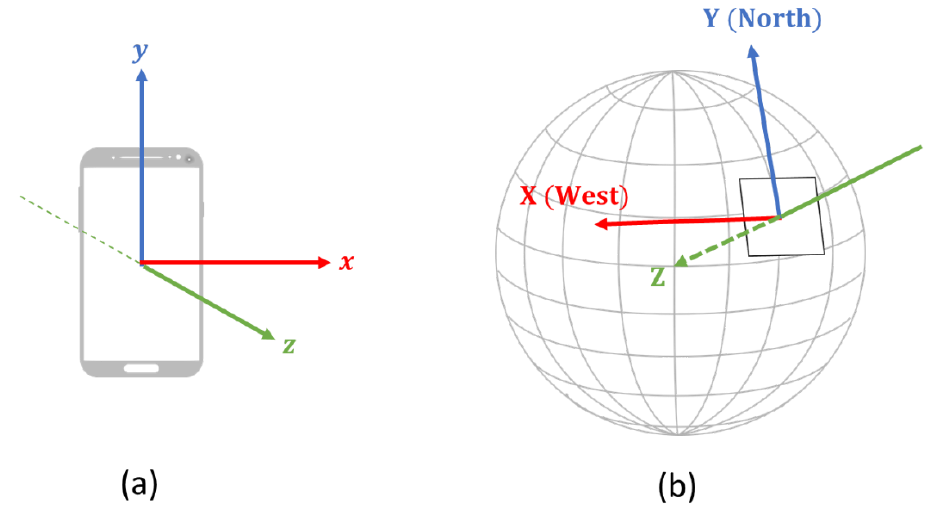
Figure 10. Coordinate systems in ( a ) local device and ( b ) global environment.